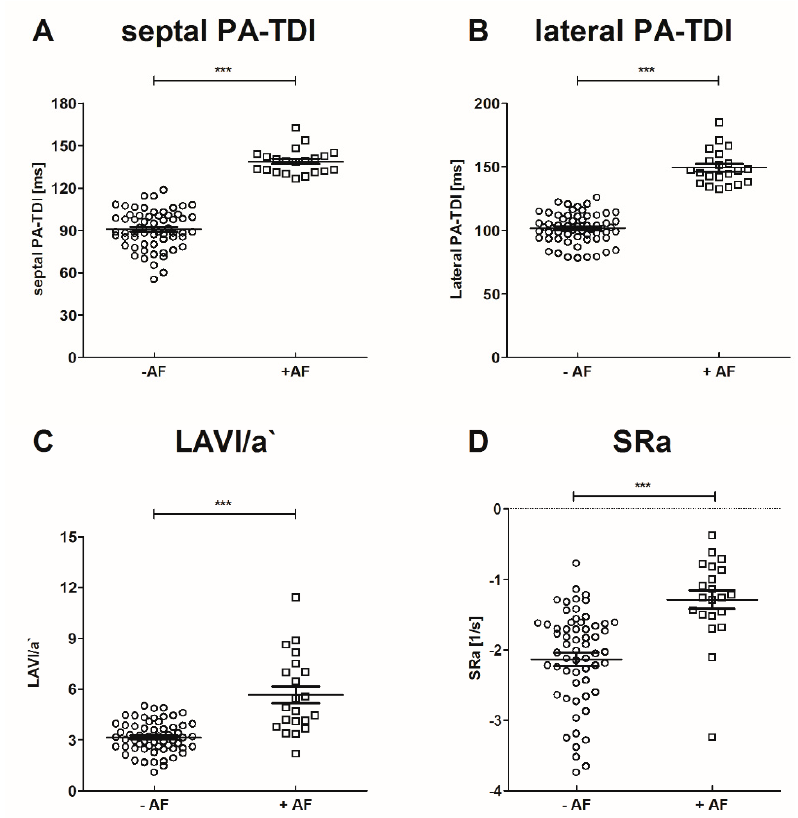
Figure 2. Echocardiographic parameters of left atrial (LA) function in patients with and without AF. *** p < 0.001.